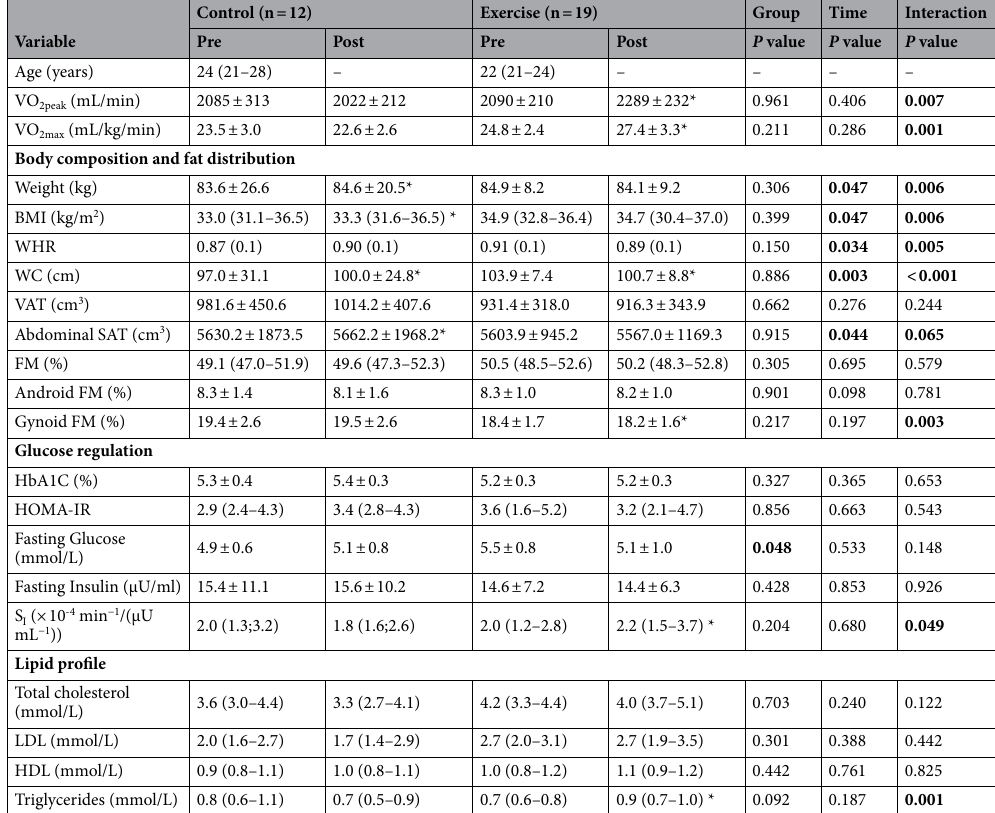
subcutaneous adipose tissue, Si insulin sensitivity, WHR waist-to-hip ratio, WC waist circumference, VAT visceral adipose tissue. * p < 0.05, significant within group change in response to the